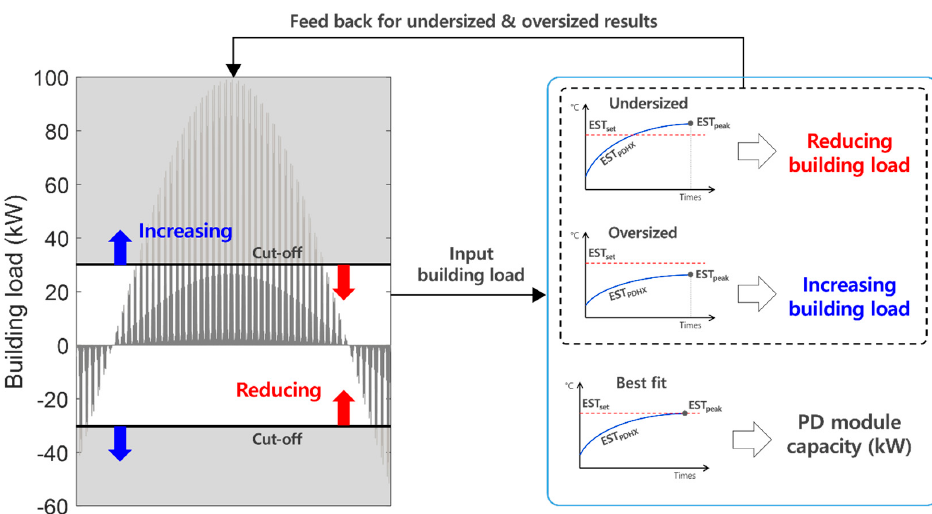
Figure 9. Sizing procedure for simulation-based PDHP system design.